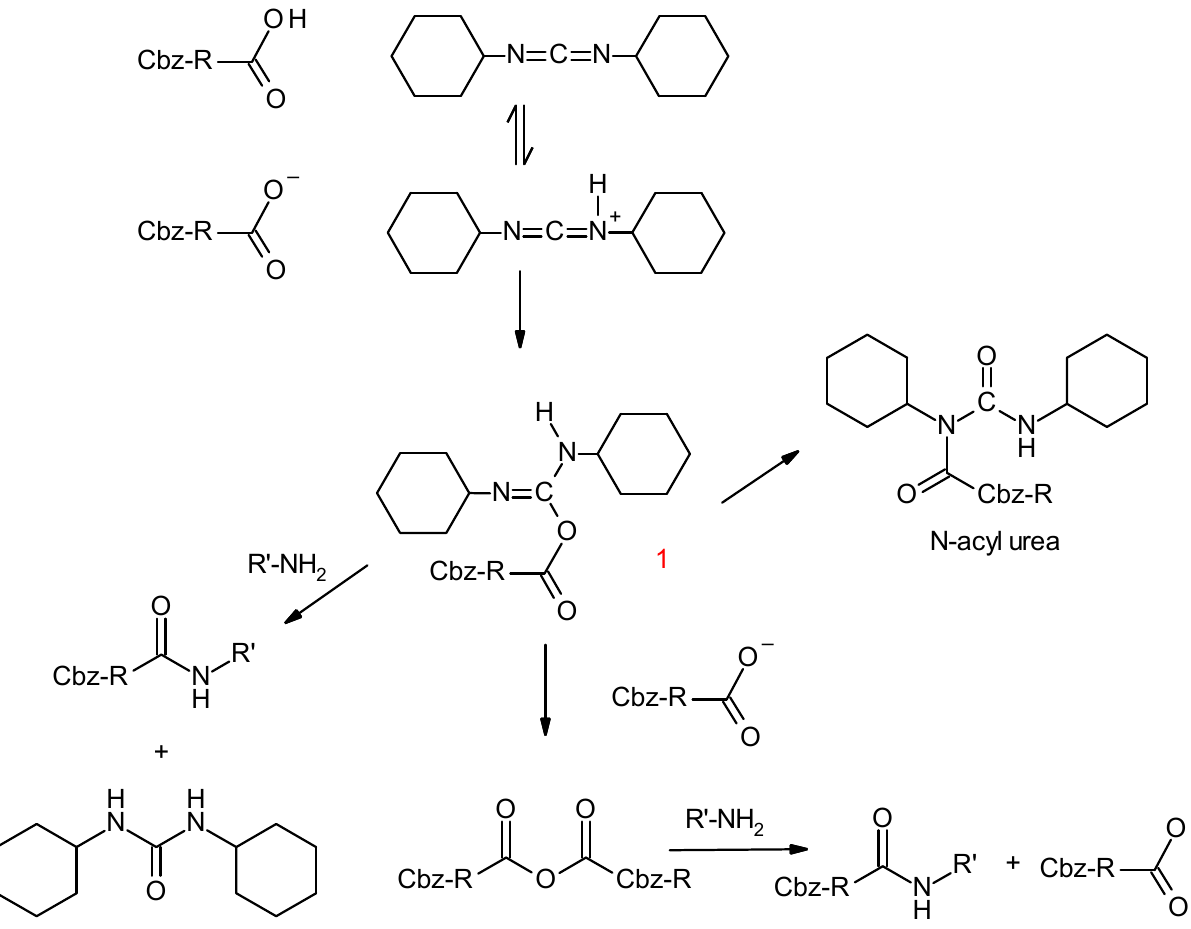
Scheme 1. Reaction scheme of dipeptide synthesis using a condensing agent DCC.